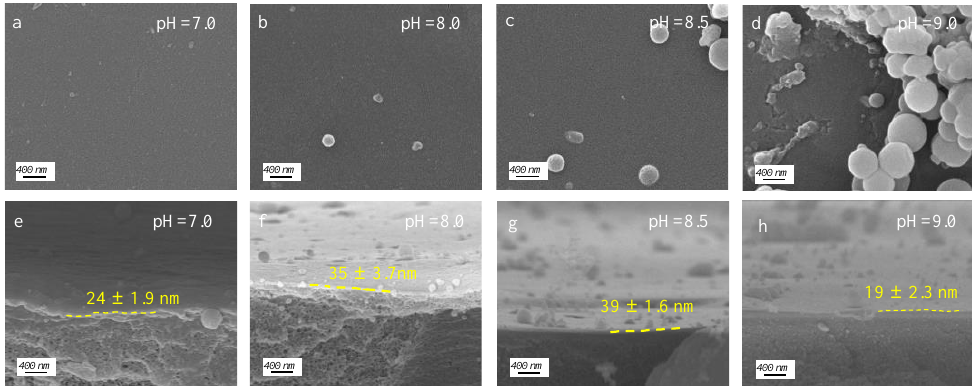
Figure 4. Surface SEM images of PG/TEPA NF membranes at ( a ) pH 7.0, ( b ) pH 8.0, ( c ) pH 8.5, ( d ) pH 9.0; cross-section SEM images of PG/TEPA NF membranes at ( e ) pH 7.0, ( f ) pH 8.0, ( g ) pH 8.5, ( h ) pH 9.0. (The effect of different pH on the membrane morphology is investigated under the condition of constant PG/TEPA = 1:1 and reaction time of 2 h.).